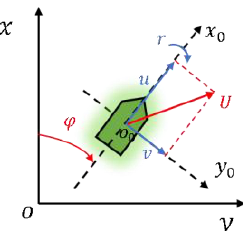
Figure 2. USV manipulation motion coordinate system. u , v , and r are the velocities on the three degrees of freedom (forward, lateral, and head) of the ship motion, respectively. ψ is the heading angle.